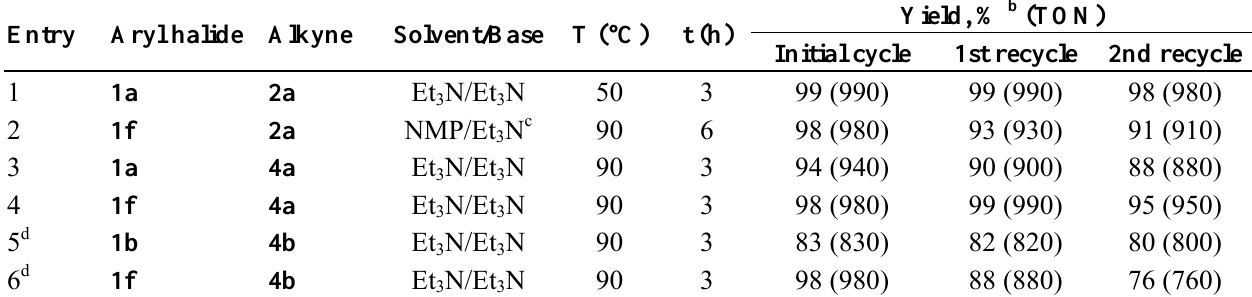
Table 4. Sonogashira coupling reaction catalyzed by recycled nanosized MCM-41-Pd. a